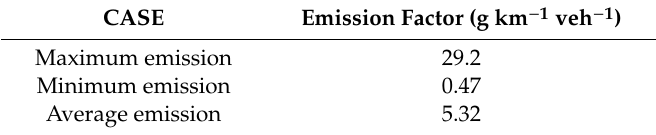
Table 4. Emission factors by di ff erent hypotheses: maximum, inventory and minimum scenarios.